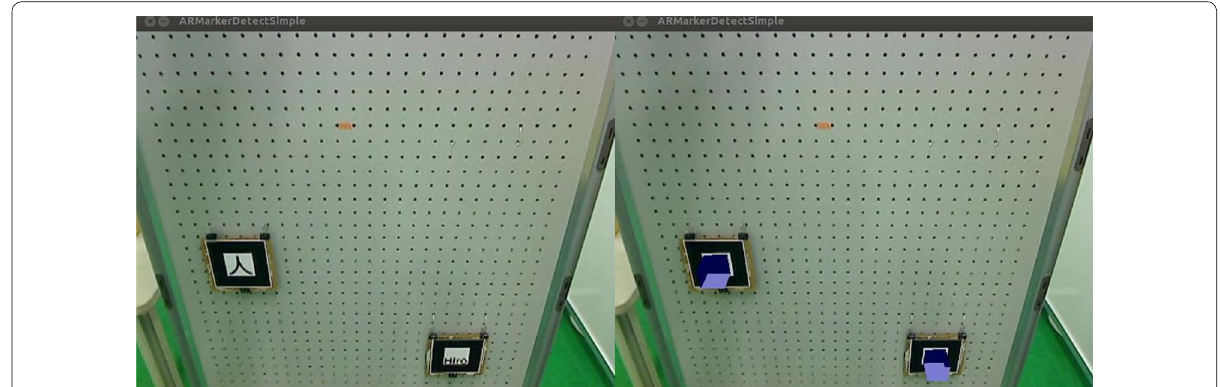
Fig. 13 Estimation of the marker position using the ARToolKit library (left: input image from the HRP-4’s camera, right: rendered blue cubes at the estimated positions)